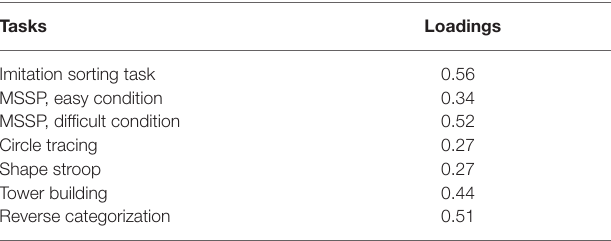
TABLE 3 | Factor loadings in the exploratory factor analysis of working memory capacity, inhibition, and shifting